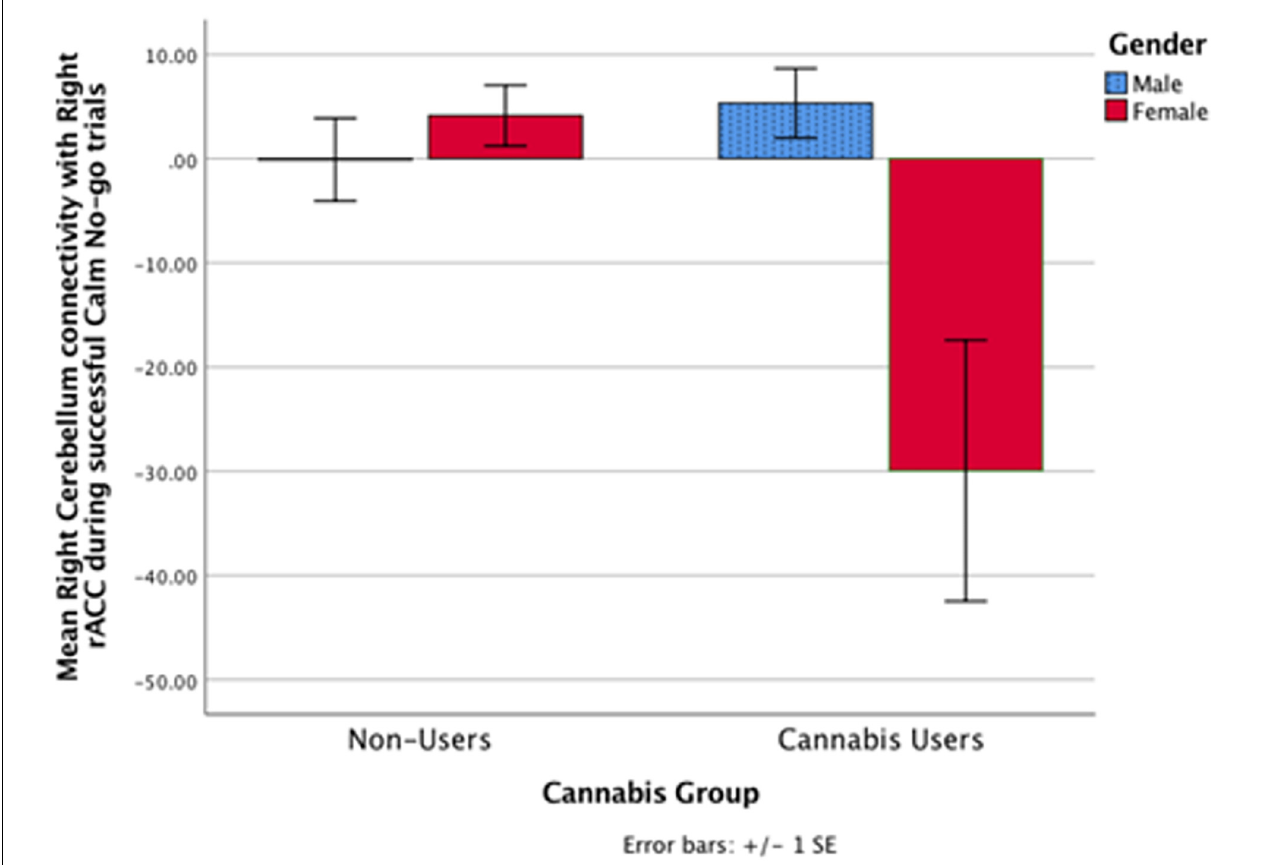
FIGURE 3 | In the cannabis-using group, the right rACC had greater functional connectivity with a cluster in the right cerebellum in males relative to females during successful calm No-go trials ( p < 0.005). Non-users did not exhibit a significant gender relationship. Notably, there was no significant cannabis × gender